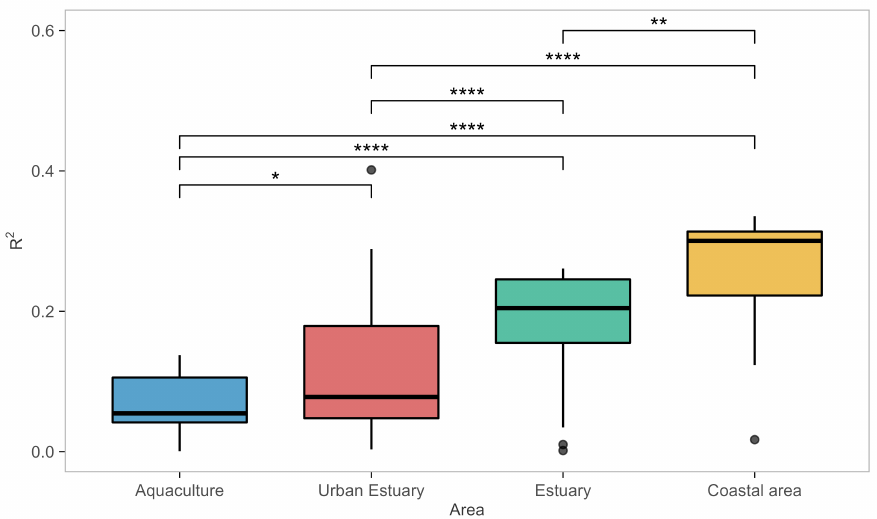
Figure 3. Boxplot of model performance measured as R 2 in different habitat types (as classified in Table 5). Model performance significantly differed between habitat types (robust ANOVA, F(3,75.561) = 49.9, p < 0.001, effect size ξ = 0.77, confidence interval CI( ξ ) = [0.68, 0.84]; Table A2). Significance codes are as follows: p ≤ 0 ‘****’, p < 0.01 ‘**’, and p < 0.5